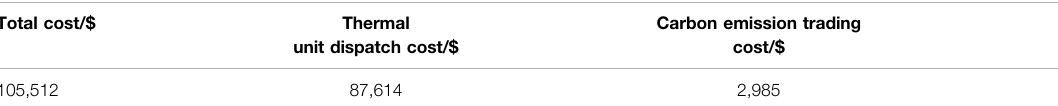
TABLE 2 | Daily operation cost of the system in Scenario 1